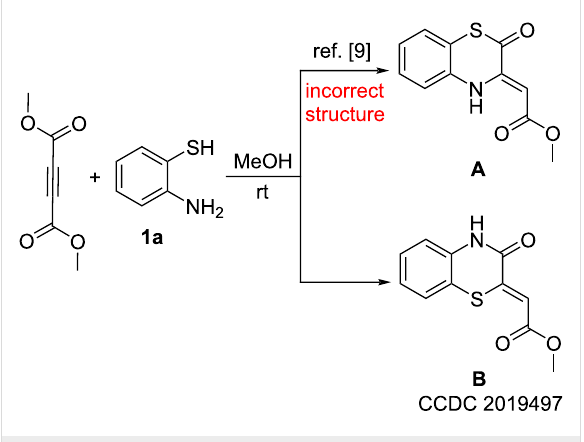
Scheme 1: Reported structure A of assayed compound [9] and its correct structure B